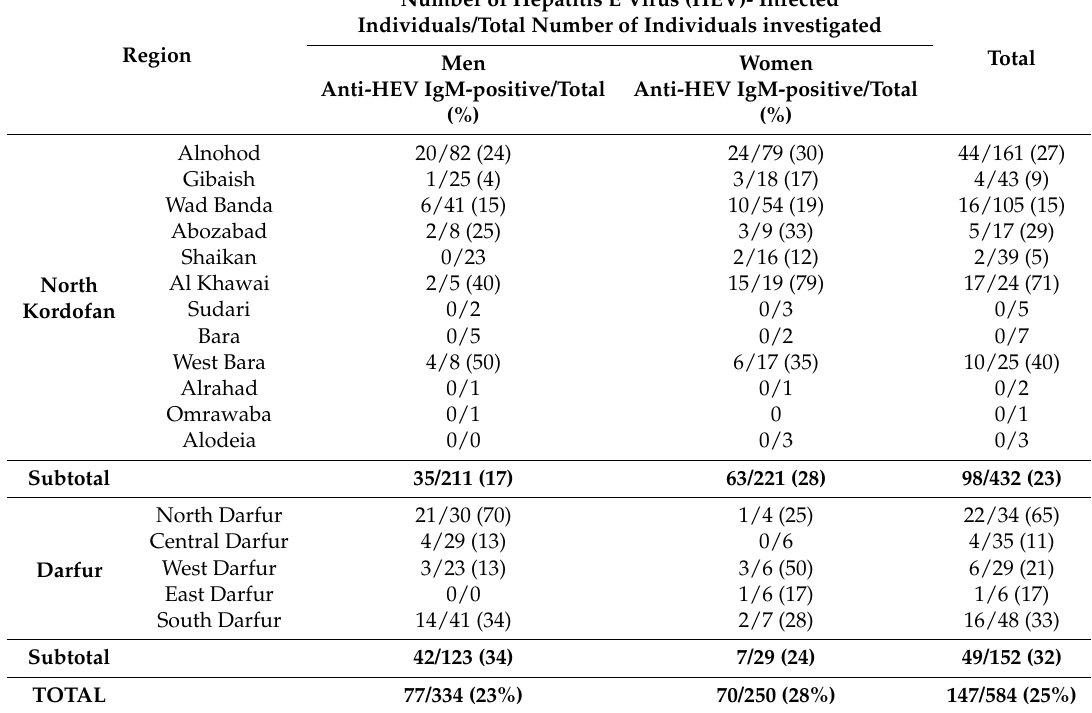
Table 1. Origin and gender of patients with sporadic hepatitis infection in 12 different regions of the state of North Kordofan during 2011 and 2012 and of patients involved in hepatitis outbreaks in five regions of Darfur during the years 2012 and 2014. Number of Hepatitis E Virus (HEV)- Infected Individuals/Total Number of Individuals investigated Region TotalMen Women Anti-HEV IgM-positive/Total Anti-HEV (%)